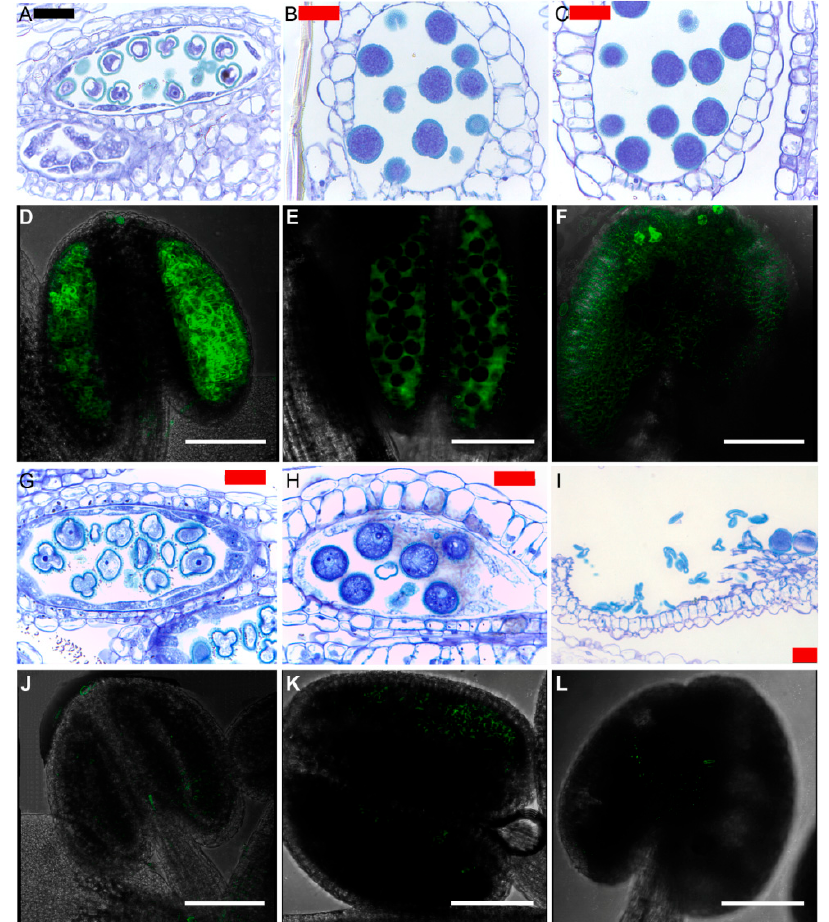
Figure 4. Pollen grain development and auxin accumulation in anthers of flowers from wild-type and 249 bdx-1 mutant Arabidopsis plants. Normal pollen grain development in wild-type (wt) flowers. ( A ) 250 Anthers from 7–8 stage flower. ( B ) Anthers from 11–12 stage flower. ( C ) Anthers from 13 stage flower. 251 GFP detection of auxins in anthers from wt /DR5 flowers. ( D ) Anthers from 7–8 stage flower. ( E ) 252